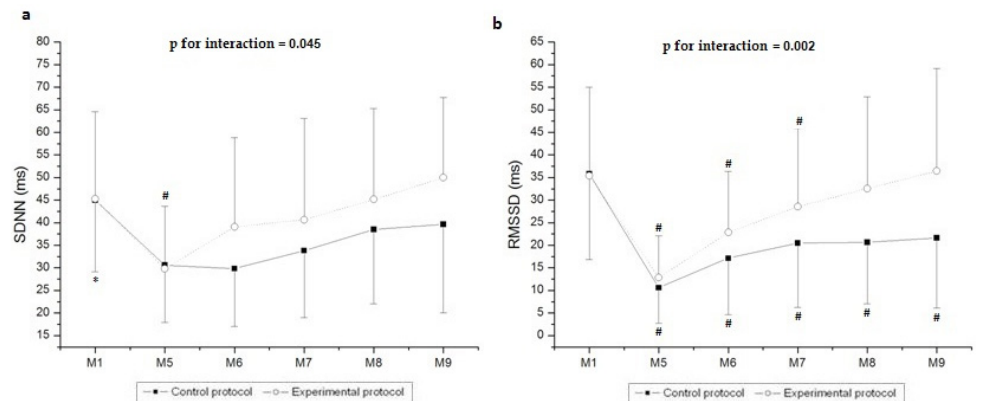
Figure 4. Values are mean ± standard deviation. ( a ) SDNN and ( b ) RMSSD during recovery and the comparison in control and experimen- tal protocols. Final 5 minutes of rest (M1) and minutes of recovery: 5–10 (M5), 15–20 (M6), 25–30 (M7), 40–45 (M8), 55–60 (M9). *Dif- ferent from M5, M6, M7, M8, and M9 ( p < 0.05); #Different from M1( p < 0.05); SDNN, standard deviation of the mean of all normal RR